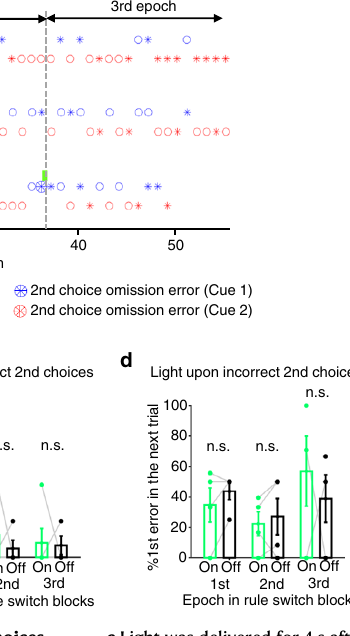
c Light was delivered for 4s after correct 2nd choices instead of incorrect 2nd choices (see Fig. 8d). 2nd choice performance was plotted for trials that immedi- atelyfolloweda2ndchoiceomissionerrortrial. P =0.544,0.780and0.641foreach epoch, respectively. Two samples t -test (two-sided), n =4 rats. Error bar, SEM. d Same as in b , but 1st choice performance was plotted for trials that immediately followed a 2nd choice omission error trial in which a light was delivered upon incorrect 2nd choices (On condition) or not delivered (Off condition). P =0.212, 0.598 and 0.913 for each epoch, respectively. Two samples t -test (two-sided), n =5 rats.Errorbar,SEM. e Sameasin c ,but1stchoiceperformancewasplottedfortrials that immediately followed a 2nd choice omission error trial in which light was delivereduponcorrect2ndchoices(Oncondition)ornotdelivered(Offcondition). P =0.640, 0.503 and 0.587 for each epoch, respectively. Two samples t -test (two- sided), n =5 rats. Error bar, SEM. Source data are provided as a Source Data fi